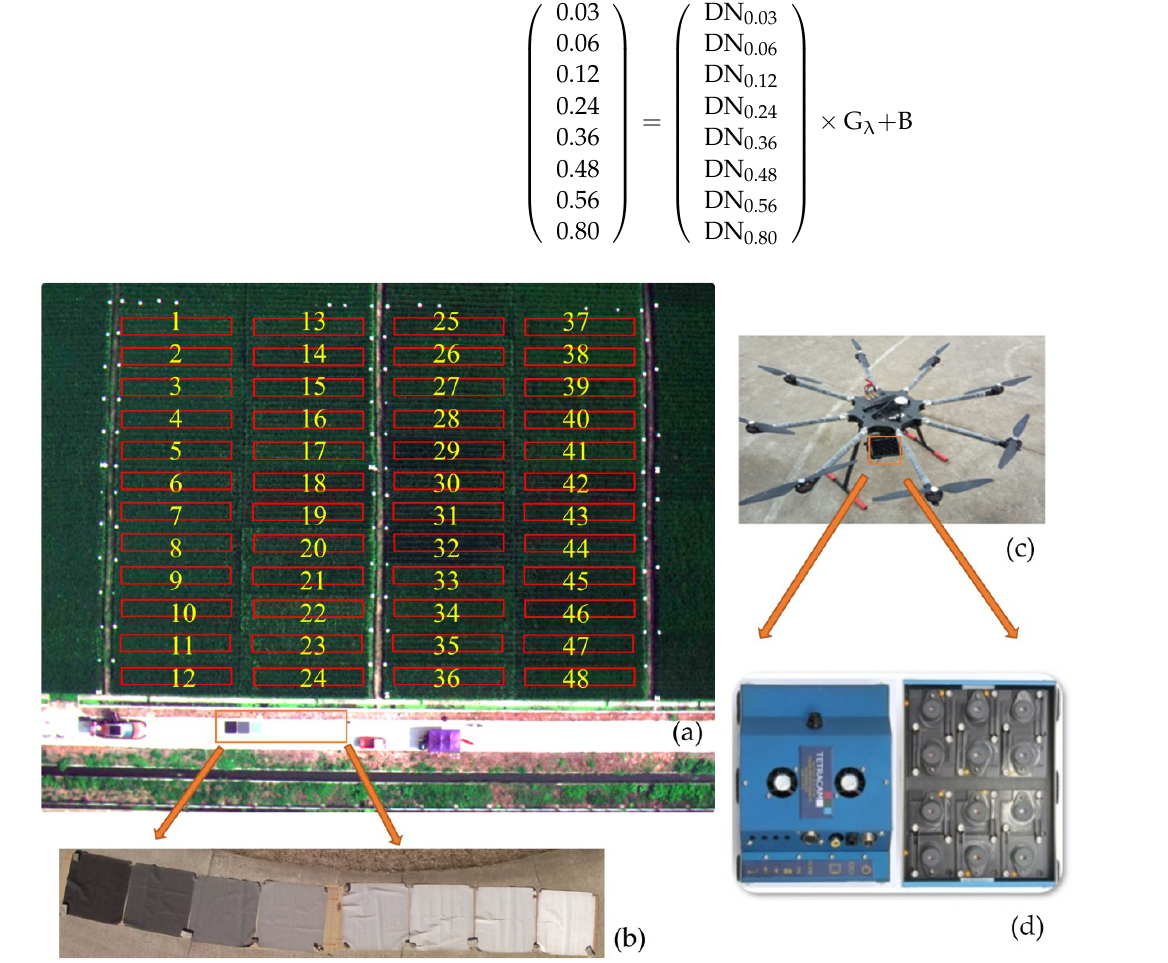
Figure 2. The illustration of ( a ) rice field photographed by UAV, 48 rice plots ( b ) eight calibration ground targets ( c ) UAV ( d ) Mini-MCA.